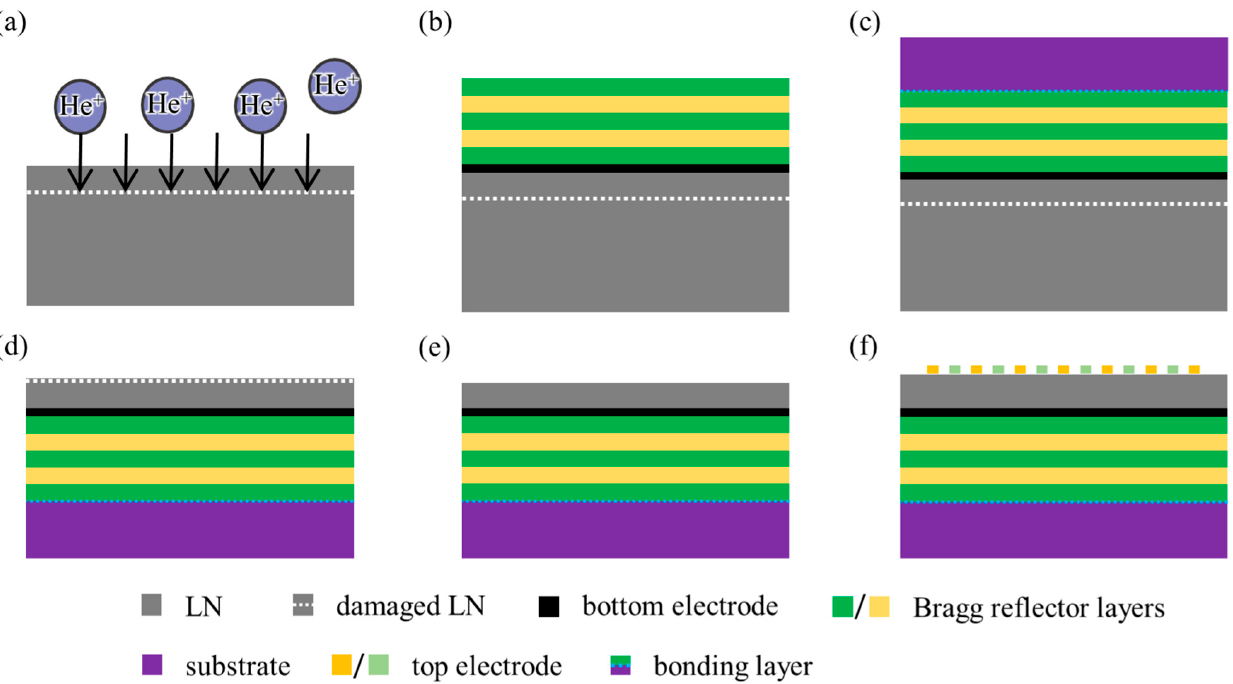
Figure 7. A possible manufacturing process for the SM-YBAR. ( a ) He+ (or H+) implantation in LiNbO 3 ; ( b ) Bottom electrode (Pt or Al) and Bragg reflector (SiO 2 , Al 2 O 3 or Pt) multilayers deposition; ( c ) Bonding to a substrate. The substrate material used in the article is Al 2 O 3 . It can have many choices according to the convenience of bonding and will not affect the device’s performance. ( d ) Thermal annealing to split the LiNbO 3 film; ( e ) Polishing; ( f ) Top electrode (Al) deposition and lithographic processing to obtain the IDTs.